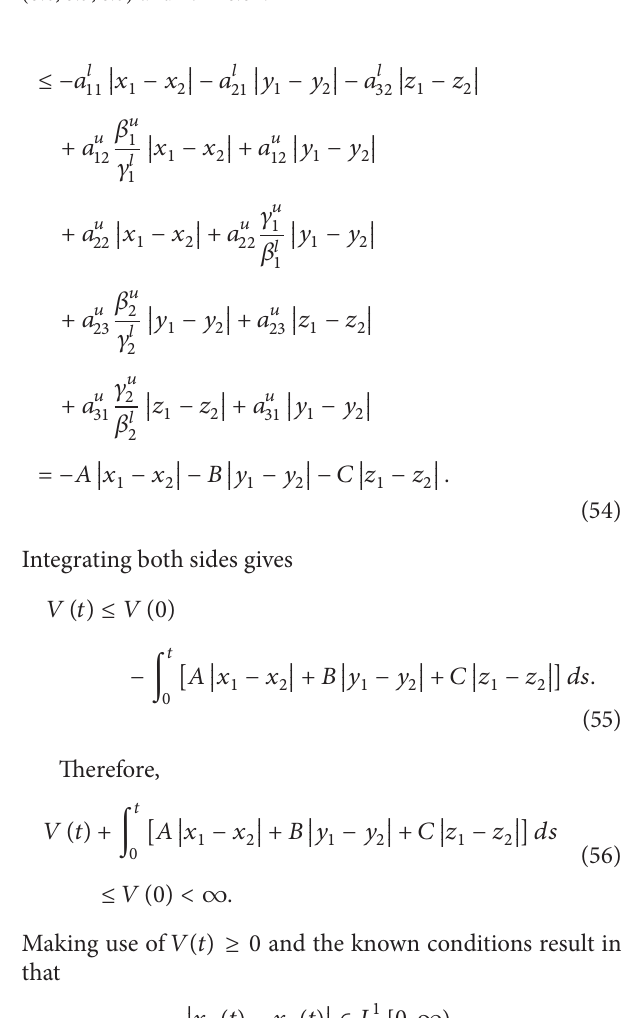
Figure 1: The curve of ln [𝑥𝑦𝑧]/ ln 𝑡 for initial values (𝑥 0 ,𝑦 0 , 𝑧 0 ) = (0.6, 0.5, 0.5) and Δ𝑡 = 0.01